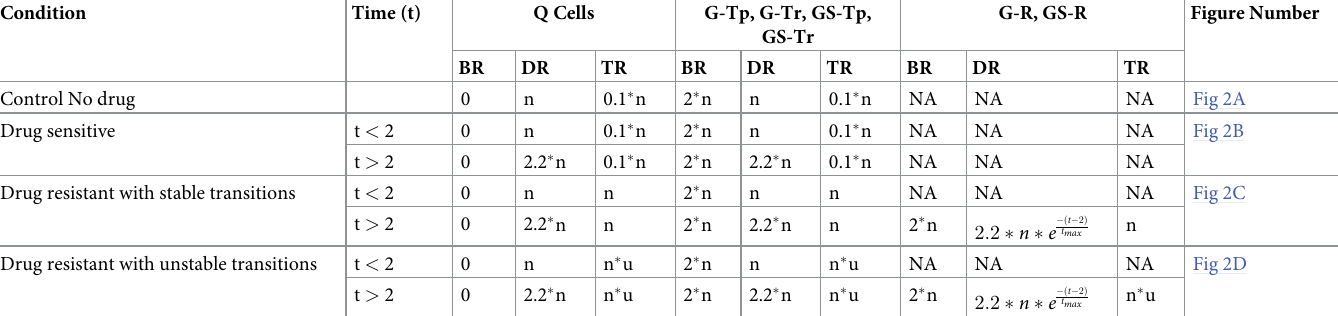
Table 1. Summary of the model simulation parameters. The various conditions and parameter values for each cell type, where n indicates the number of cells in a state; u is a random number parameter generating instability in the transitions; t is the time elapsed in the system; and t max is the maximum time allowed in the simulations. BR: birth rate, DR: death rate and TR: transition